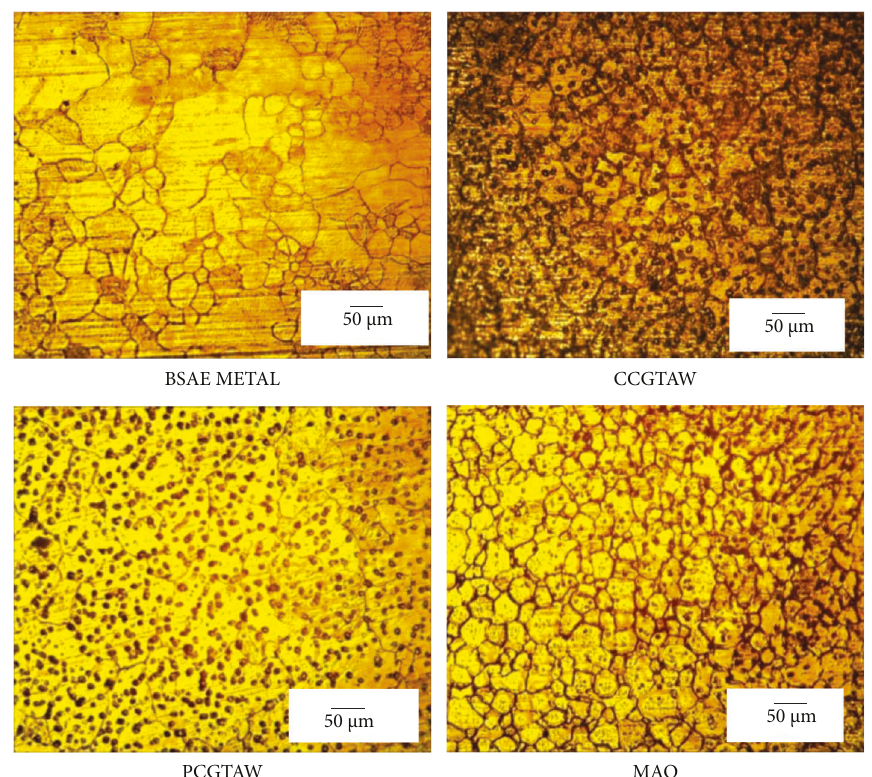
Figure 6: Fusion zone microstructures of autogenous